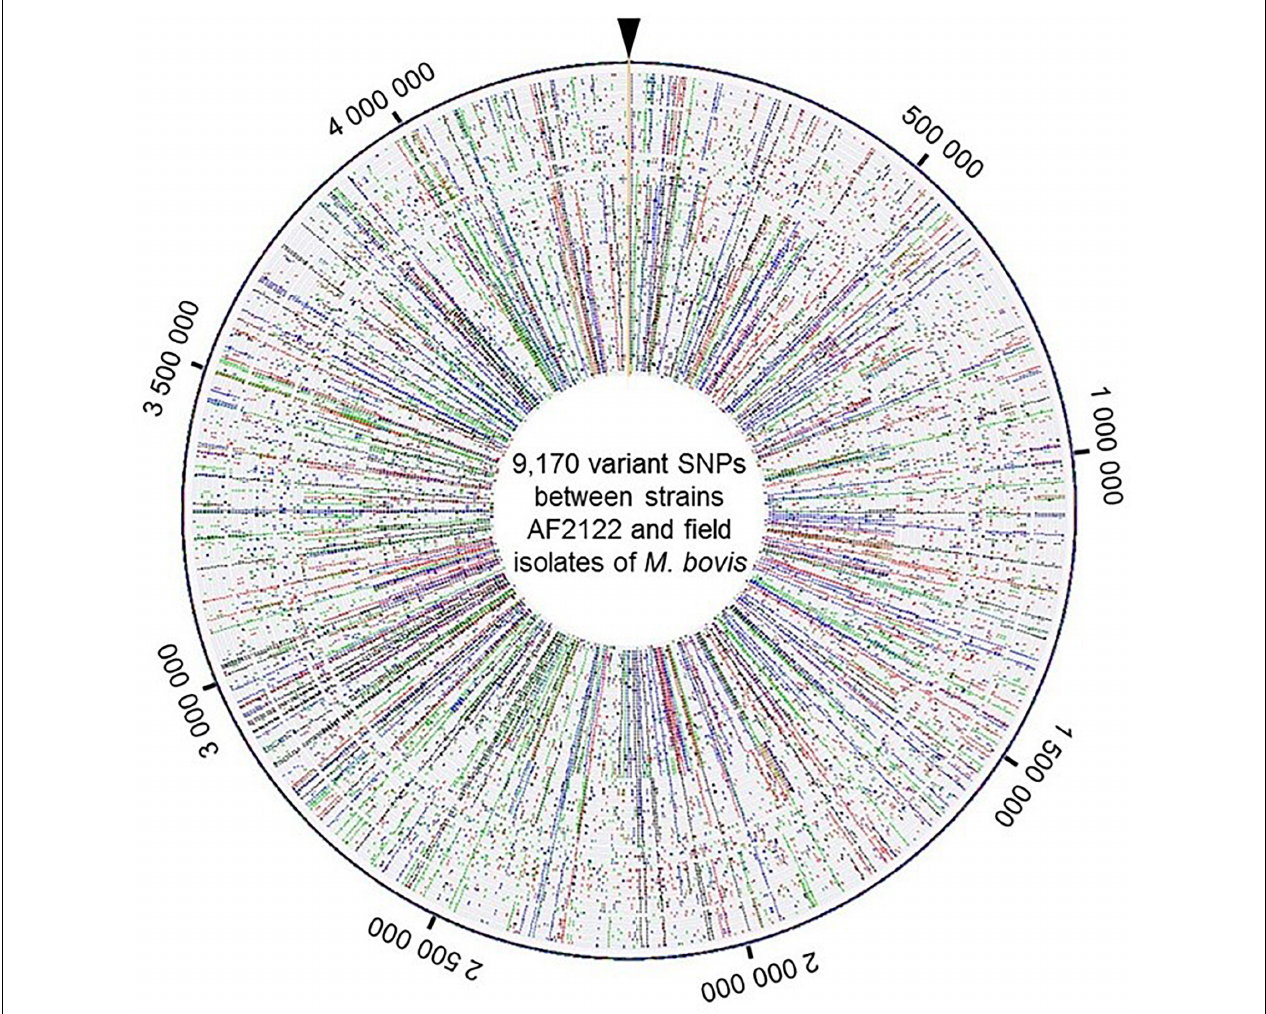
FIGURE 2 | View of the genome wide distribution of the 9,170 variant SNPs identified between the strains AF2122/97 and the 87 field isolates of M. bovis . Maps were generated using Bionumerics software. Each circle corresponds to one strain genome. The field isolate genomes were arranged by genotype group from the reference genome depicted at the outer circle. Around the outer circle are indicated the genome positions (base pair). The base changes are shown in different colors: A in green, C in blue, G in black, and T in red.